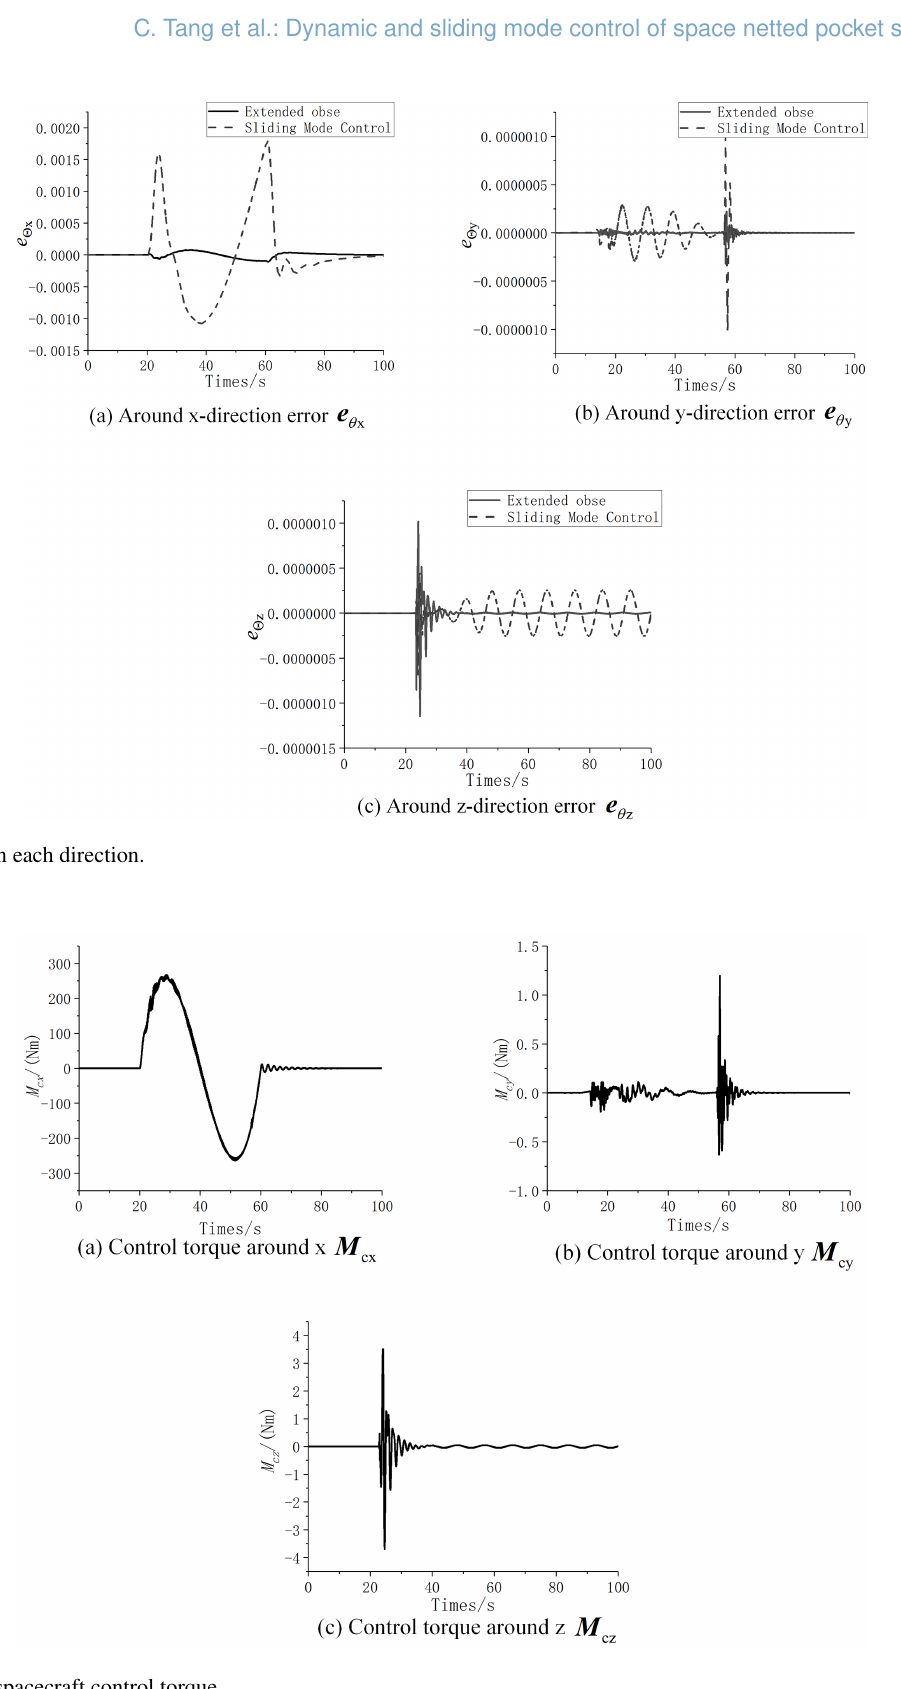
Figure 10. Service spacecraft control